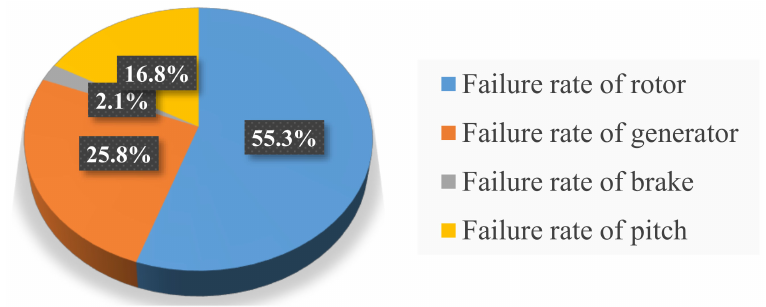
Figure 10. Proportion of failure rate for main